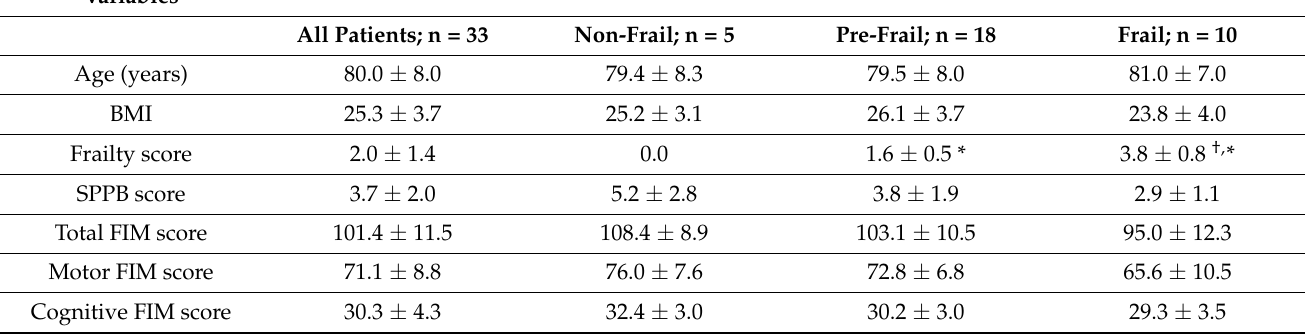
Table 1. Baseline characteristics of the participants (all and by their frailty status). Results are expressed as means ±